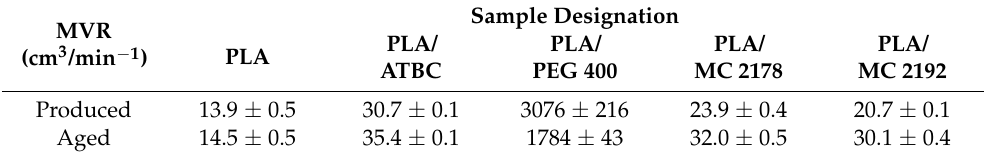
Table 3. The evaluated results of Volume-Flow Rate (MVR) for as-produced and aged PLA films. Sample Designation MVR PLA (cm 3 /min − 1 )